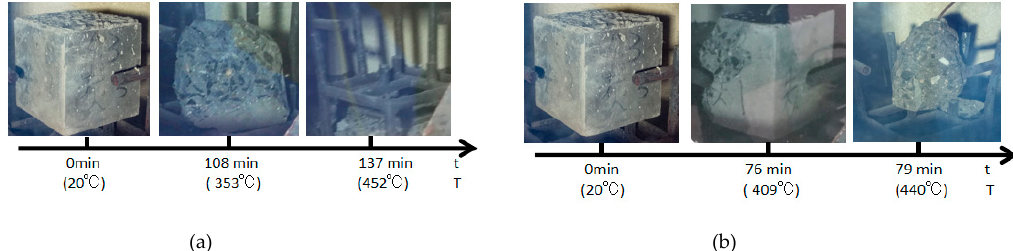
( b ) a heat rate of 5 ◦ C/min.